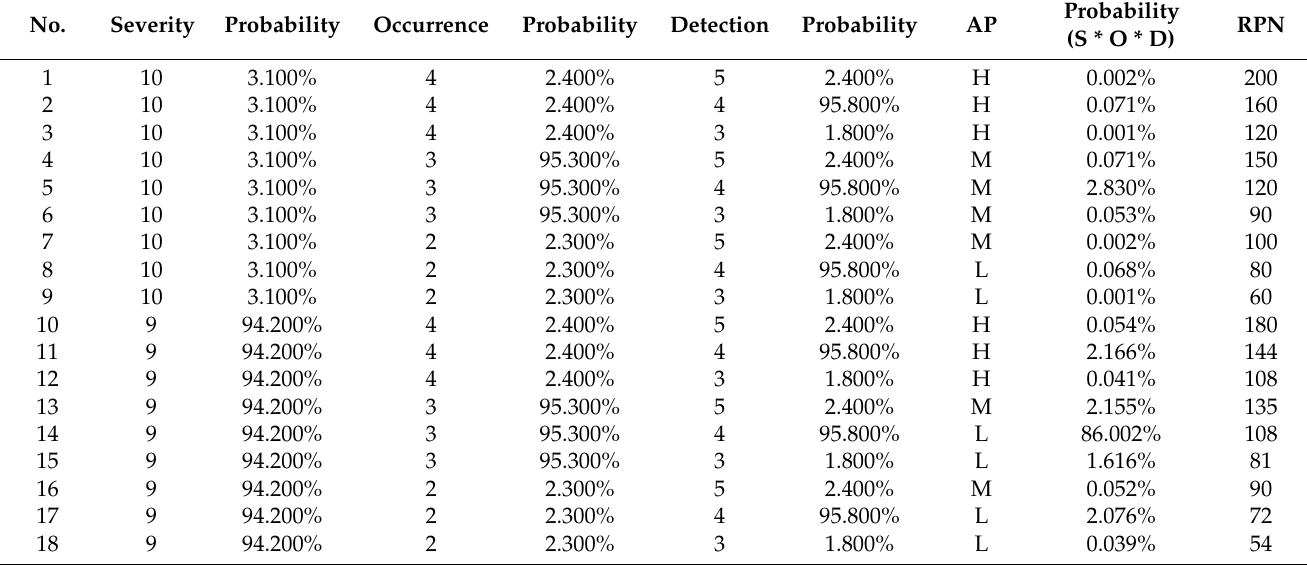
Table 8. Case 2: Order, probability, AP, and RPN of 27 combinations of S, O,